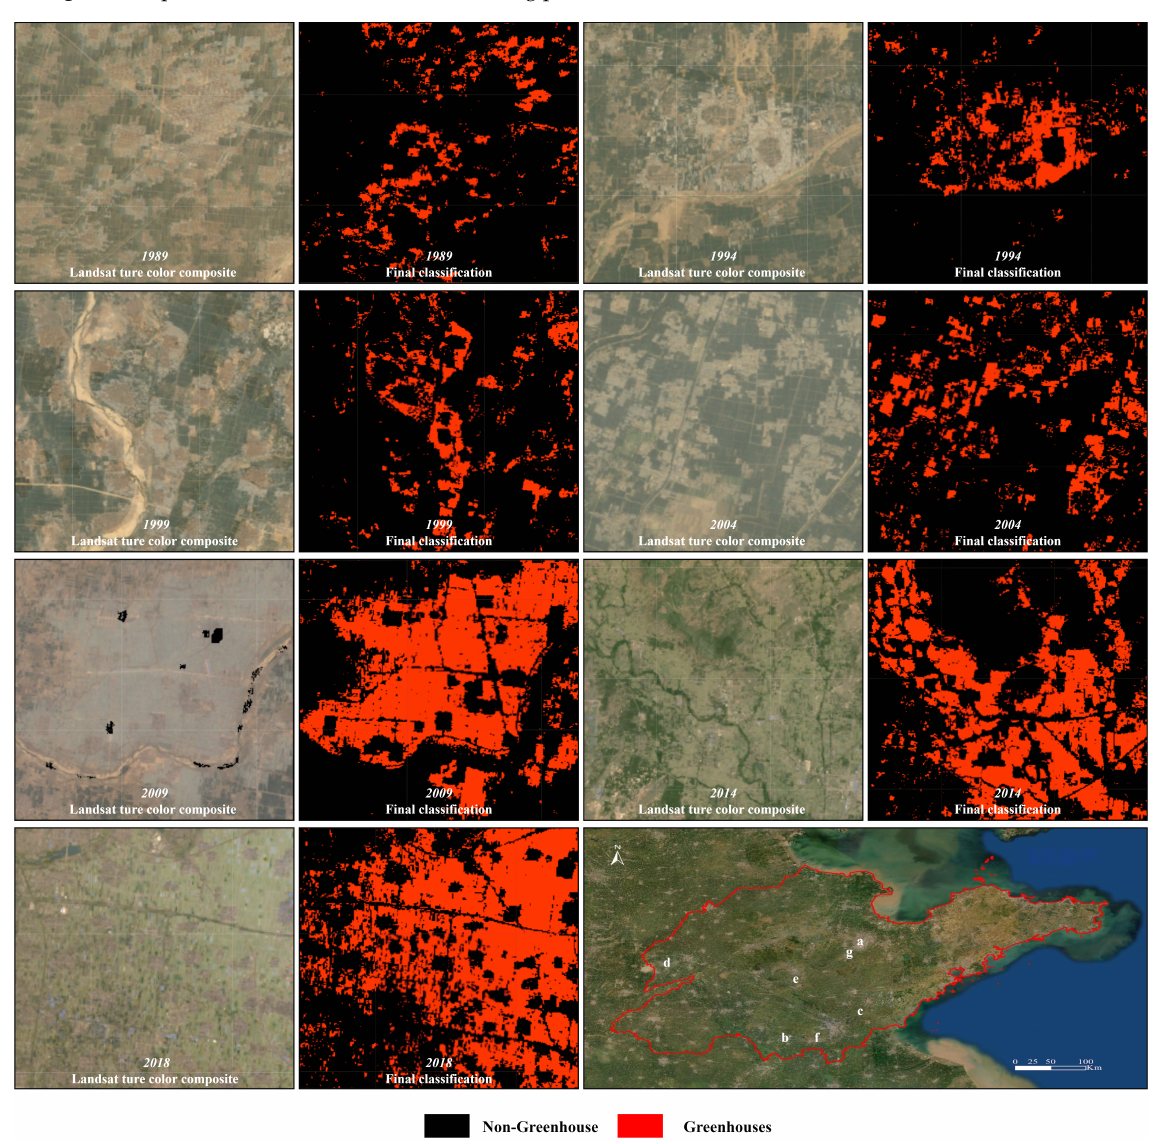
Figure 16. Landsat image examples (ture color composite) for greenhouses in 1989 ( a ), 1994 ( b ), 1999 ( c ), 2004 ( d ), 2009 ( e ), 2014 ( f ) and 2018 ( g